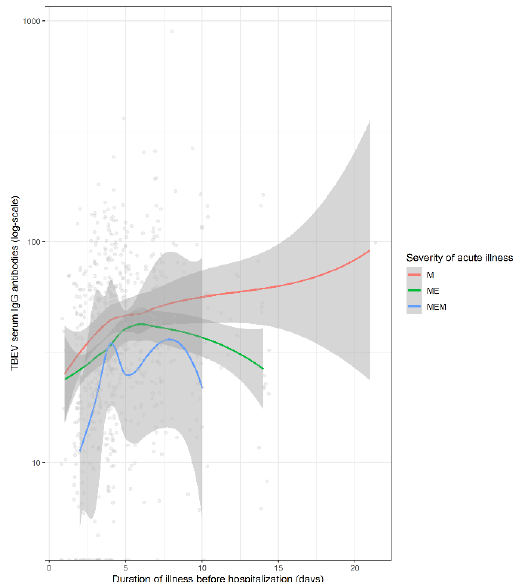
Figure 2. Serum tick-borne encephalitis virus IgG antibody levels (log-scale) according to main clinical manifestation. Legend: TBEV, tick-borne encephalitis virus; M, meningitis; ME,